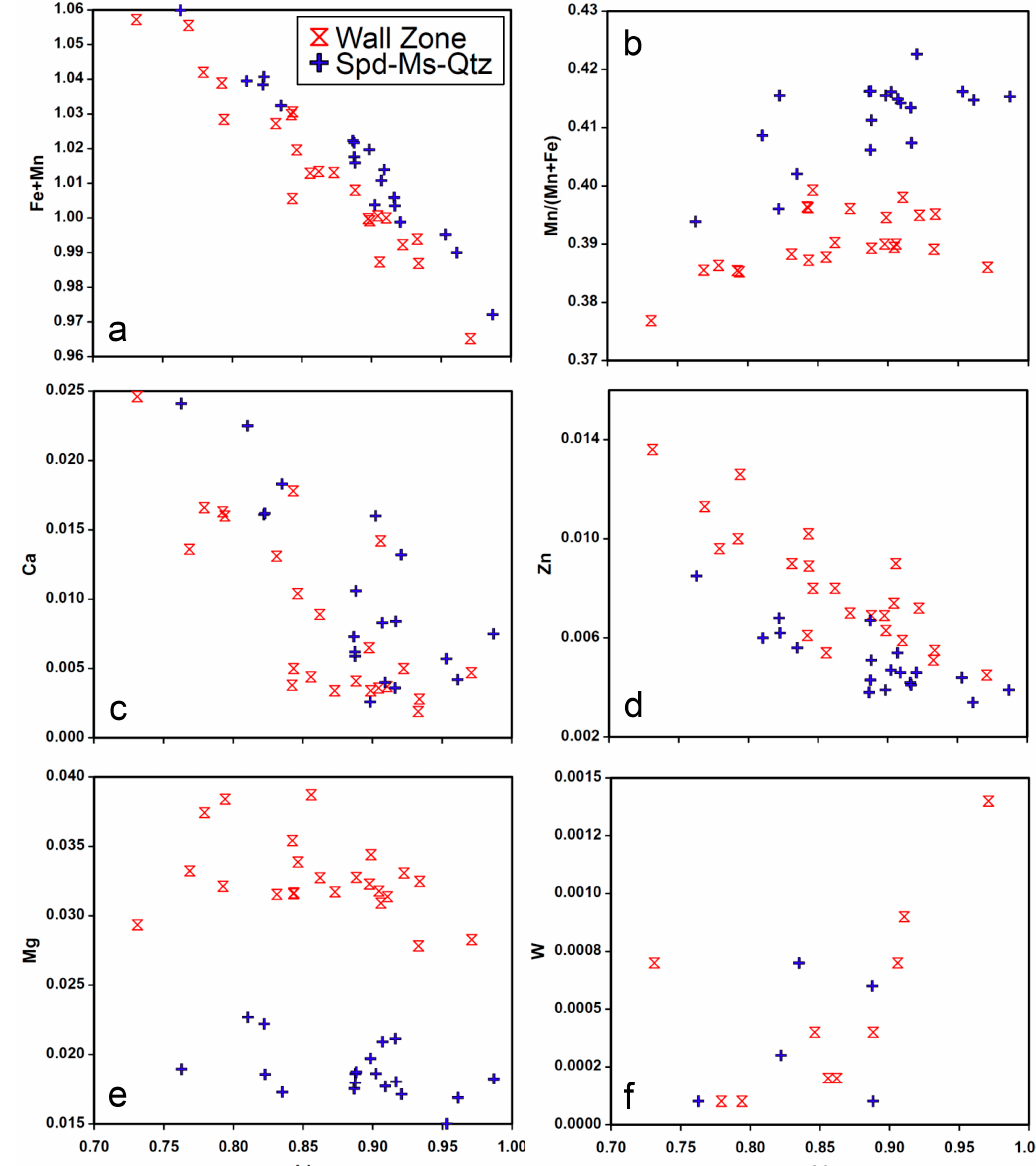
Figure 8. Binary plots for cassiterite based on EPMA data (in a.p.f.u.). ( a ) Nb + Ta vs. Sn binary plot and ( b ) Fe + Mn vs. Nb + Ta binary plot. The hydrothermal and magmatic evolutionary paths of cassiterite compositions are cited from Breiter et al. [13].